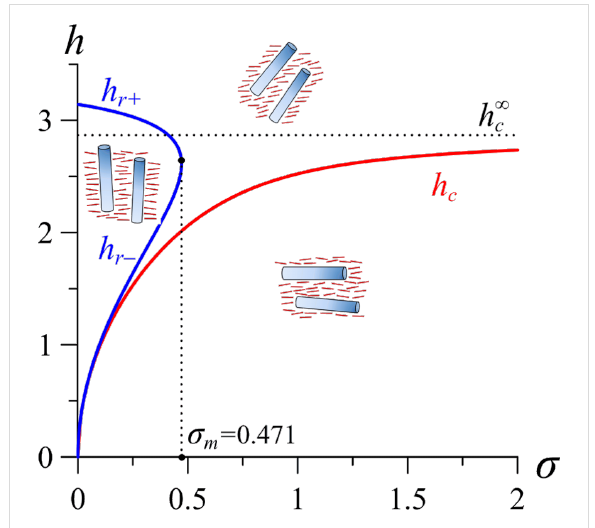
Figure 2: Diagram of orientation phases of the NLC–CNT mixture for γ = 0.2. The horizontal dotted line corresponds to the Fréedericksz field = 2.868 under the condition of rigid anchoring between the